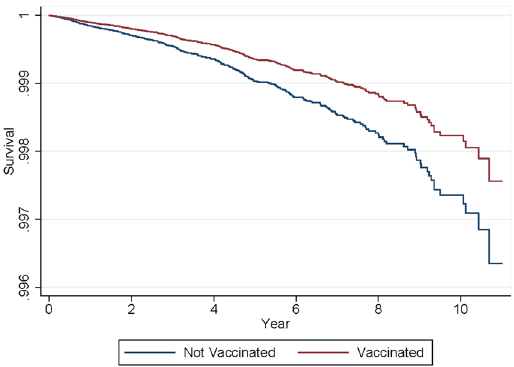
Figure 2. Cox Proportional Hazards Survival Curve for the Incidence of Type 1 Diabetes Comparing Infants who Completed the Rotavirus Vaccination Series and Infants who were not Vaccinated for Rotavirus, 2006– 2017.